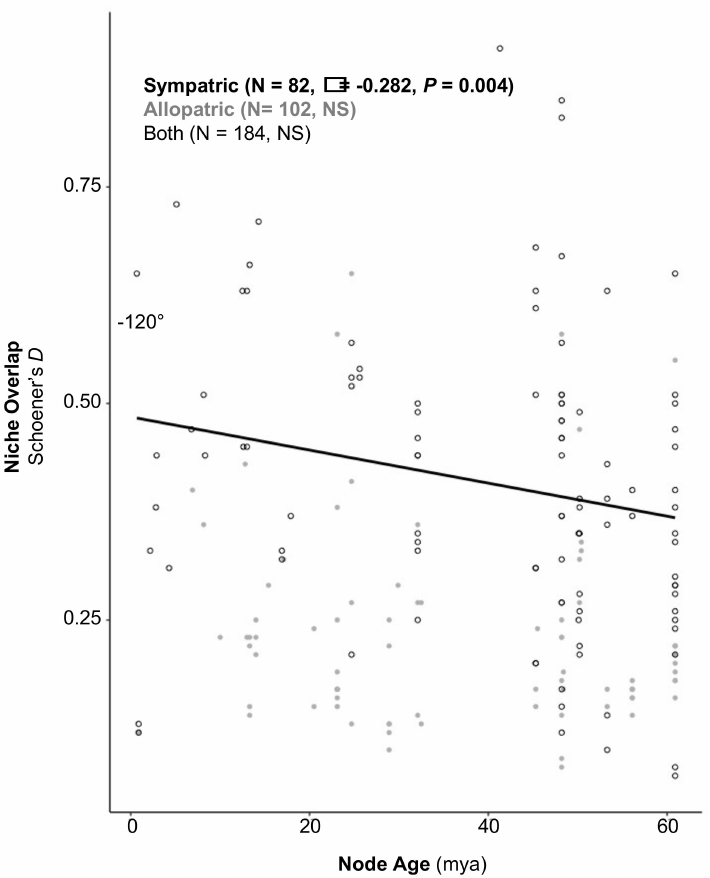
Figure 3. Node age (mya) and degree of climatic niche overlap ( D , in which D = 1 indicates total overlap and D = 0 indicates no overlap) were uncorrelated for all taxa pairs considered and for allopatric pairs (gray, closed circles). However, recently diverging sympatric taxa pairs (black open circles) had significantly more similar climatic niches than did more distantly diverging taxa (simple linear regression line shown, adjusted R 2 = 0.04). Full dataset can be accessed in Table